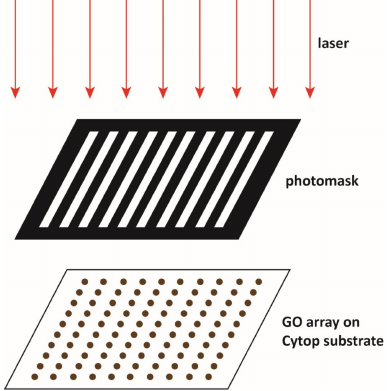
Figure 1. Setup of the gradient of low-level laser irradiation on the cultured stem cells.